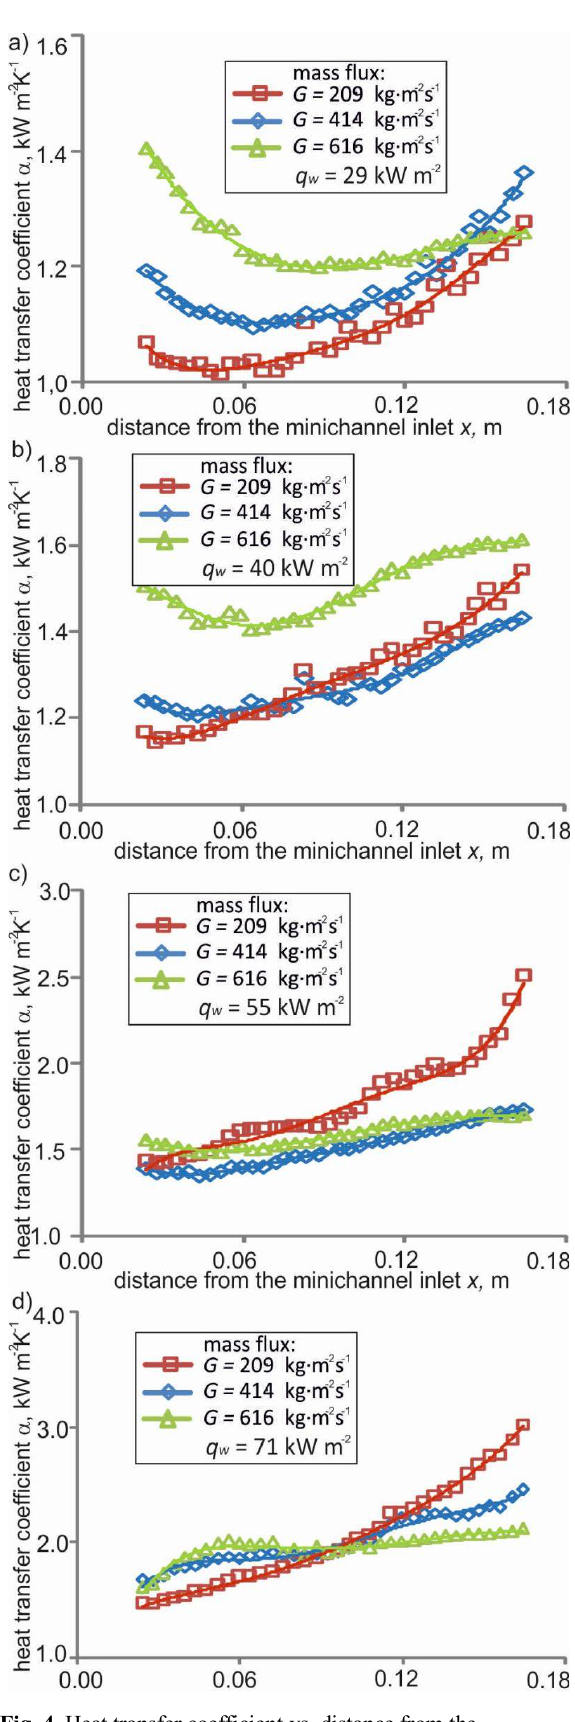
Fig. 4. Heat transfer coefficient vs. distance from the minichannel length obtained for the subcooled boiling region at three mass fluxes.